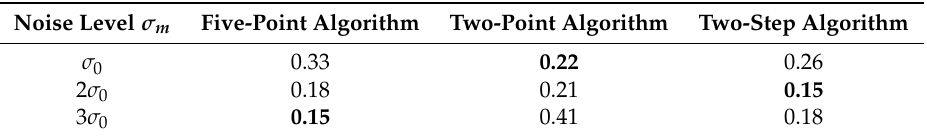
Table 1. Accuracy of the algorithms for estimating the essential matrix varying the magnetometer measurement